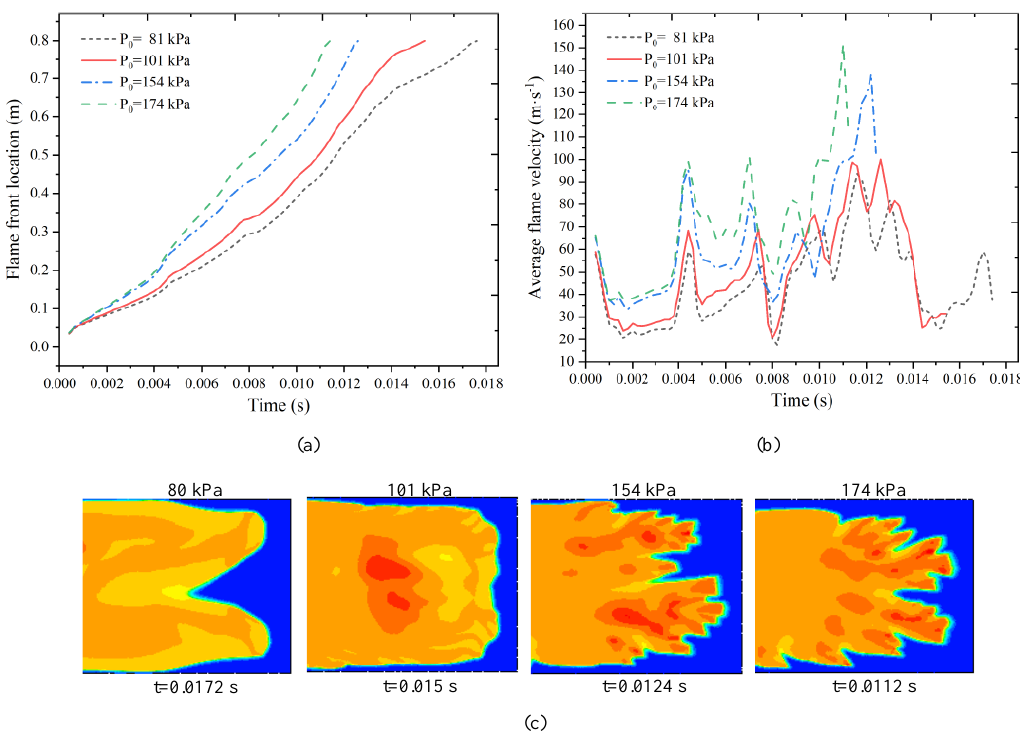
Figure 8. Effects of the initial pressure on the flame propagation: ( a ) flame front position vs. time; ( b ) average flame velocity vs. time; ( c ) comparison of the flame front close to the open end under different initial pressure.